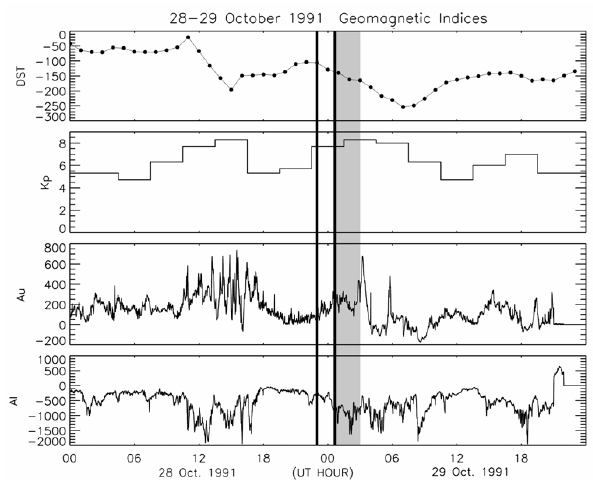
Fig. 2. Geomagnetic indices Dst , Kp , AU and AL for the storm Figure 2. Geomagnetic indices Dst, Kp, AU and AL for the storm period 28-29 period 28–29 October 1991. The period of optical observations at October 1991. The period of optical observations at Millstone Hill is shown by the shaded time period, and the times of two DMSP passes Millstone Hill is shown by the shaded time period, and the times of are indicated by the solid vertical lines. two DMSP passes are indicated by the solid vertical